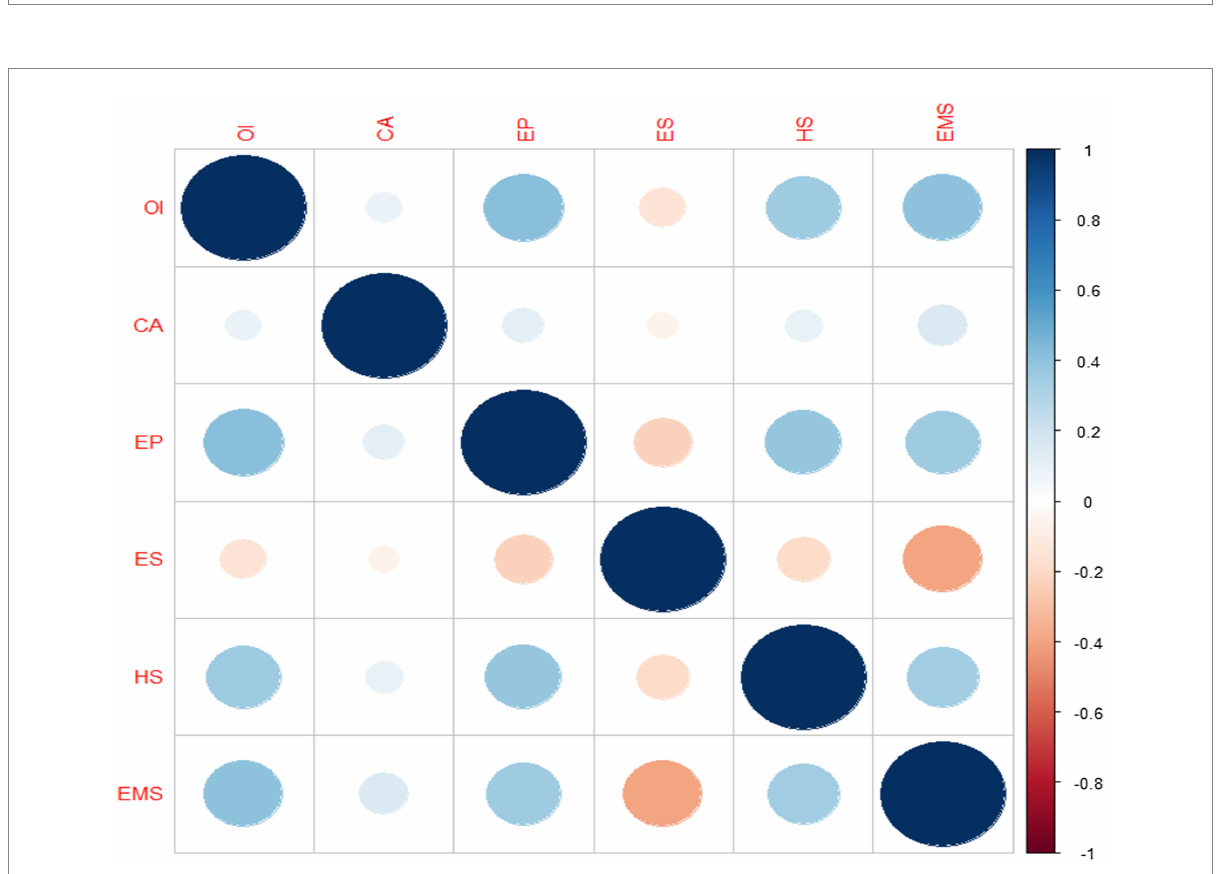
FIGURE 3 Correlation